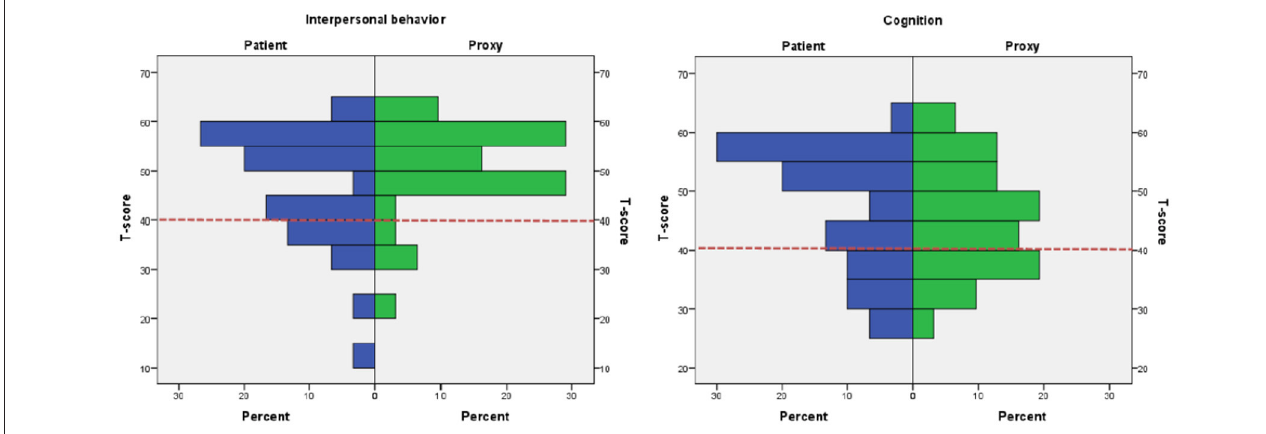
FIGURE 1 | Histograms depicting patient vs. proxy ratings on the major domains Interpersonal Behavior and Cognition. Proxy and patient ratings on Interpersonal Behavior and Cognition. Red dotted line indicates the cut-off of T -score 40.